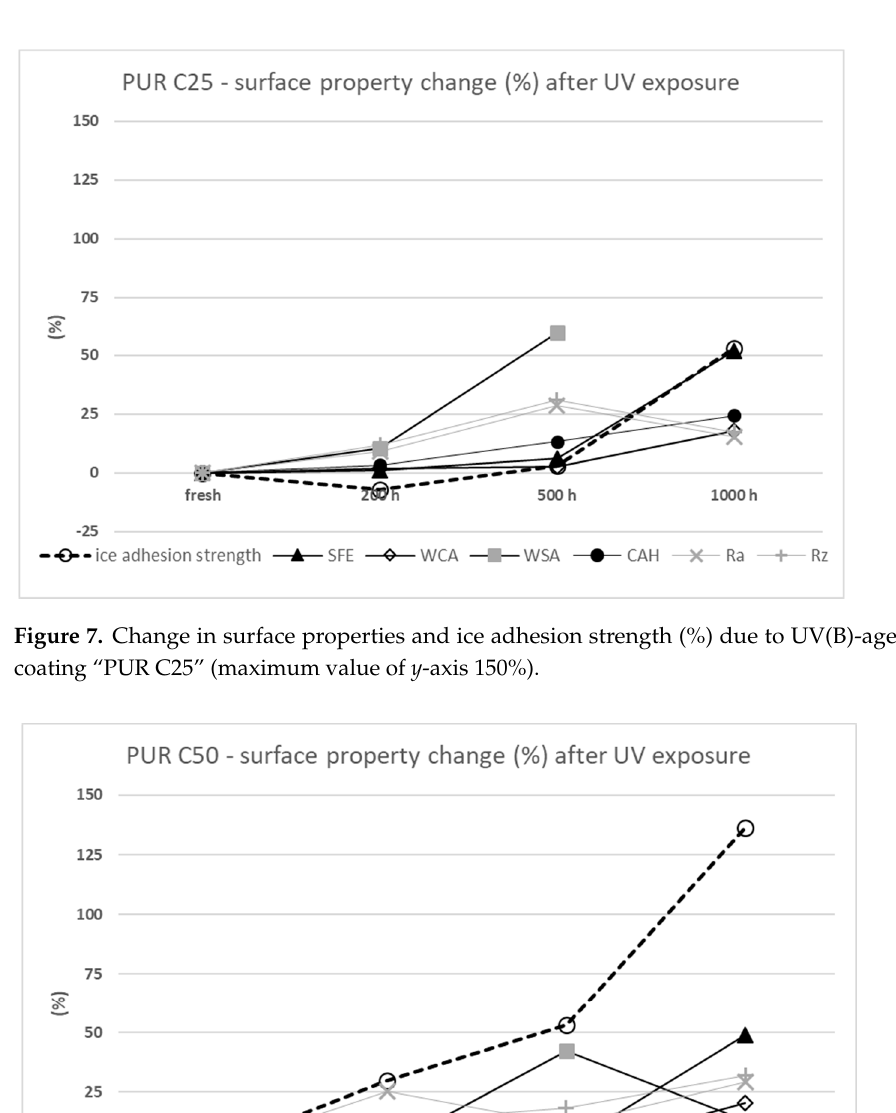
Figure 6. Change in surface properties and ice adhesion strength (%) due to UV(B)-ageing of the coating “PUR B” (maximum value of y -axis 225%).